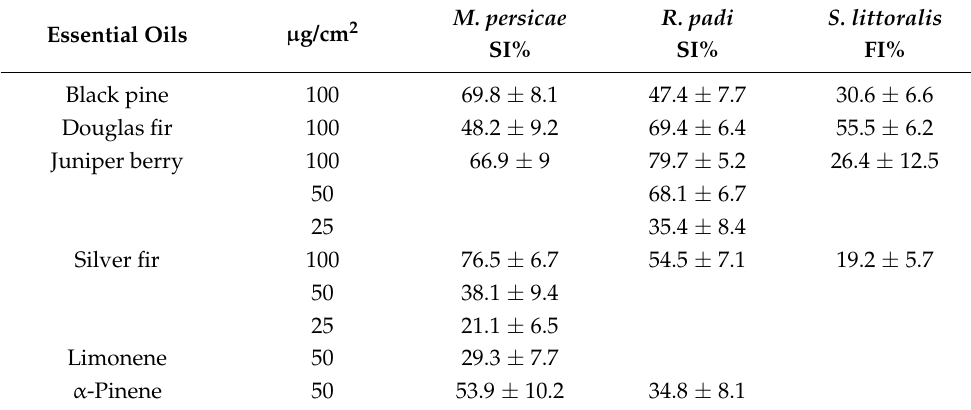
Table 2. Insect antifeedant activity of coniferous essential oils.